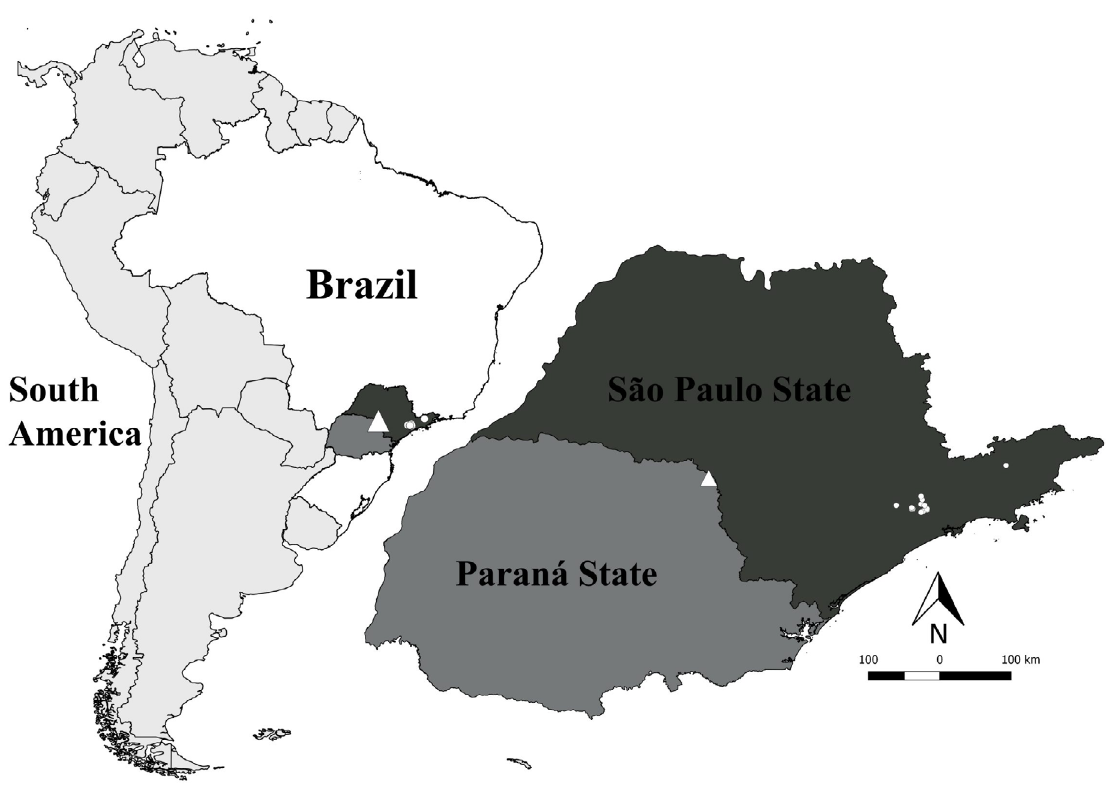
Figure 1. Map showing records of Procambarus clarkii (Girard, 1852) in Brazil. White circles indicate previous records from Magalhães et al. (2005) and Loureiro et al. (2015). White triangle represents the present